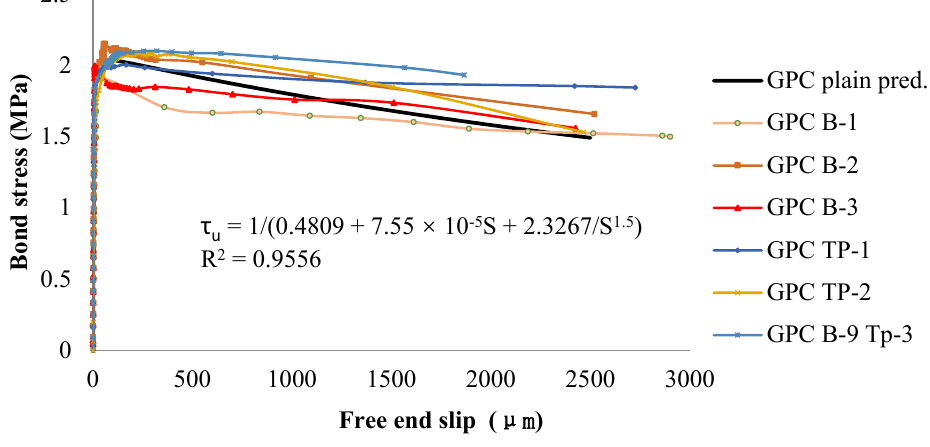
Figure 14. Bond–slip graphs of plain bar reinforced GPC.